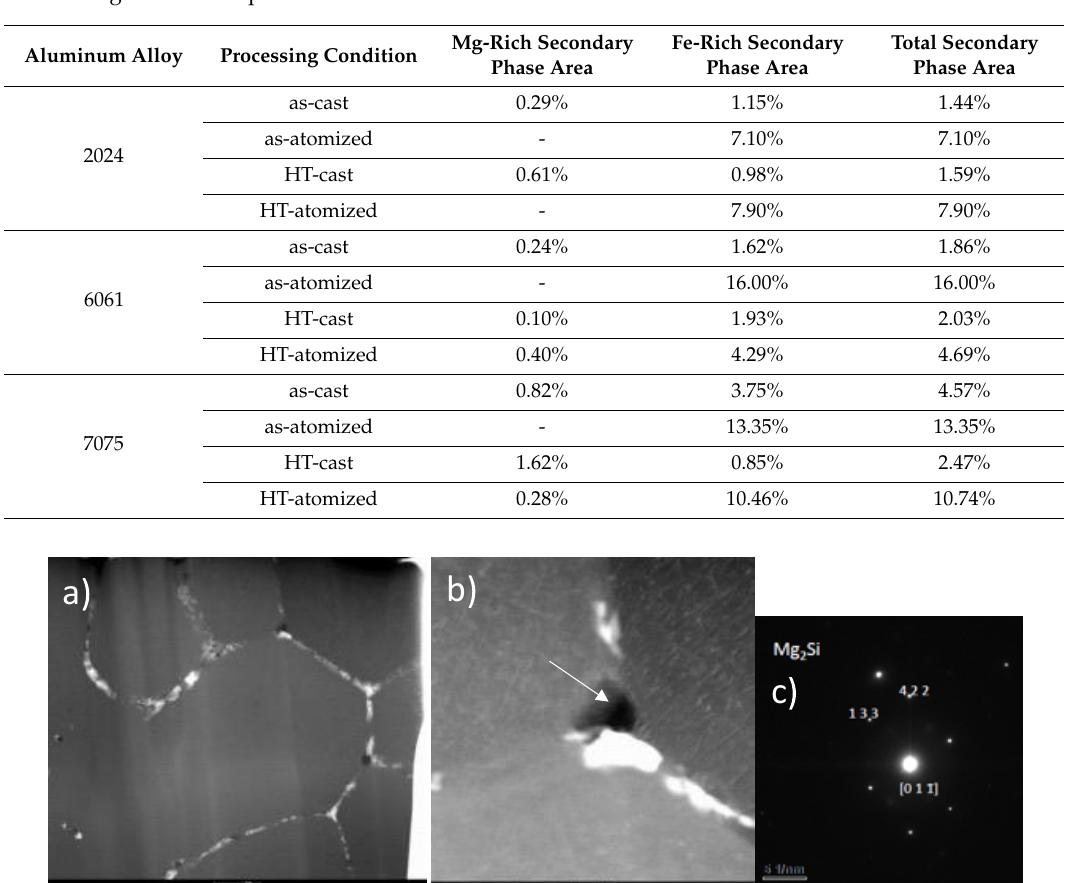
Table 4. The phase area percentages for the as-cast, as-atomized, thermally treated casts, and thermally treated gas-atomized powders.